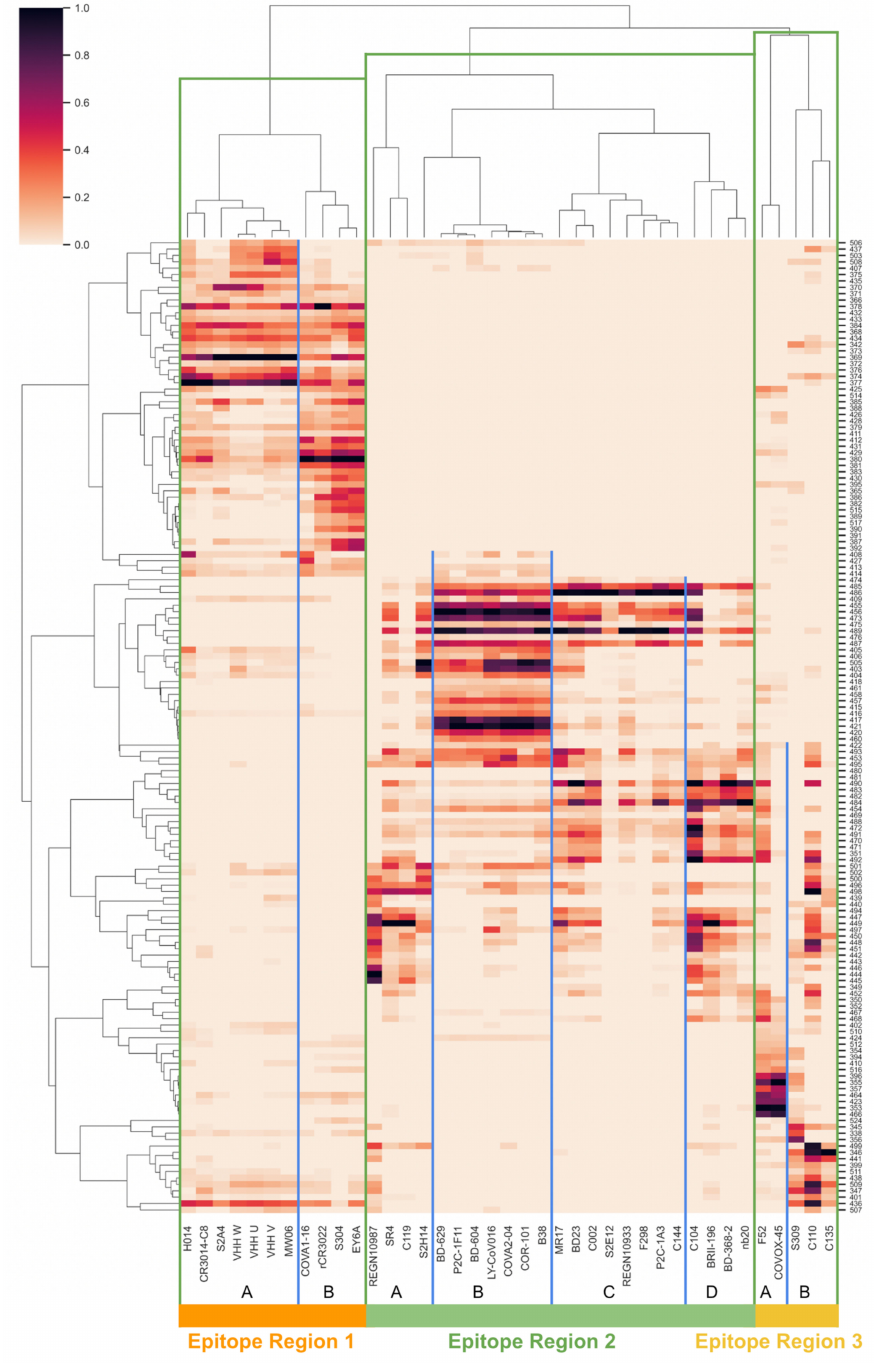
Figure 1. RBD Epitope-Paratope Interaction Matrix. The epitope-paratope interaction (EPI) matrix summarizes interactions between the set of Abs/nanobodies and all antigenic sites on RBD. The